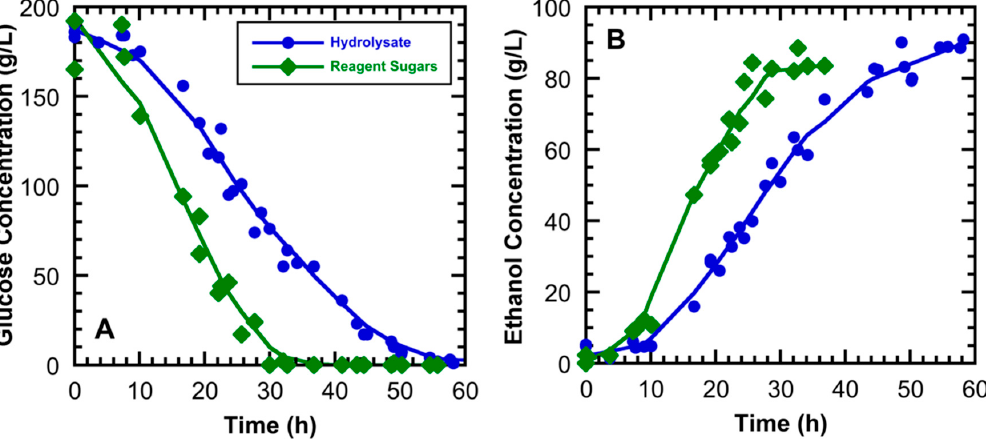
Figure 5. Comparison of fermentation efficiency and kinetics on high gravity hydrolysate and reagent-grade sugar fermentations by S. pastorianus . ( A ) Glucose; ( B ) ethanol. Cultures in sugarcane bagasse hydrolysate (Hydrolysate, (cid:8) ). Cultures in reagent-grade sugars (Reagent Sugars, (cid:7) ). Data represent the combined data from four replicate cultures per culture condition; all data points shown. To obtain a uniform hydrolysate, the hydrolysates from four fed-batch reactions were combined. The legend for both panels is shown in panel (A). All data points are shown for the four replicates. The